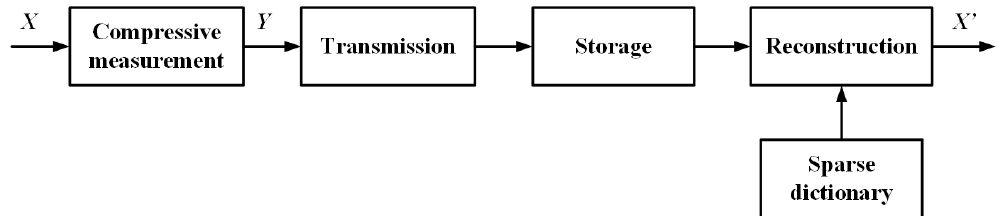
Figure 1. The basic framework of CS